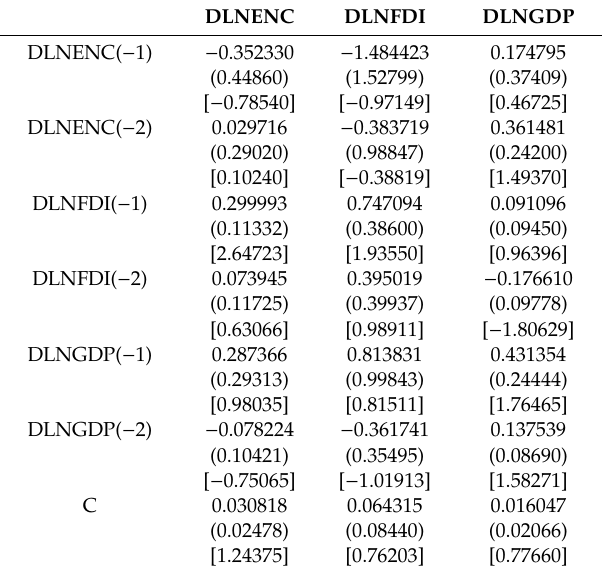
Table 8. Vector autoregression estimates.